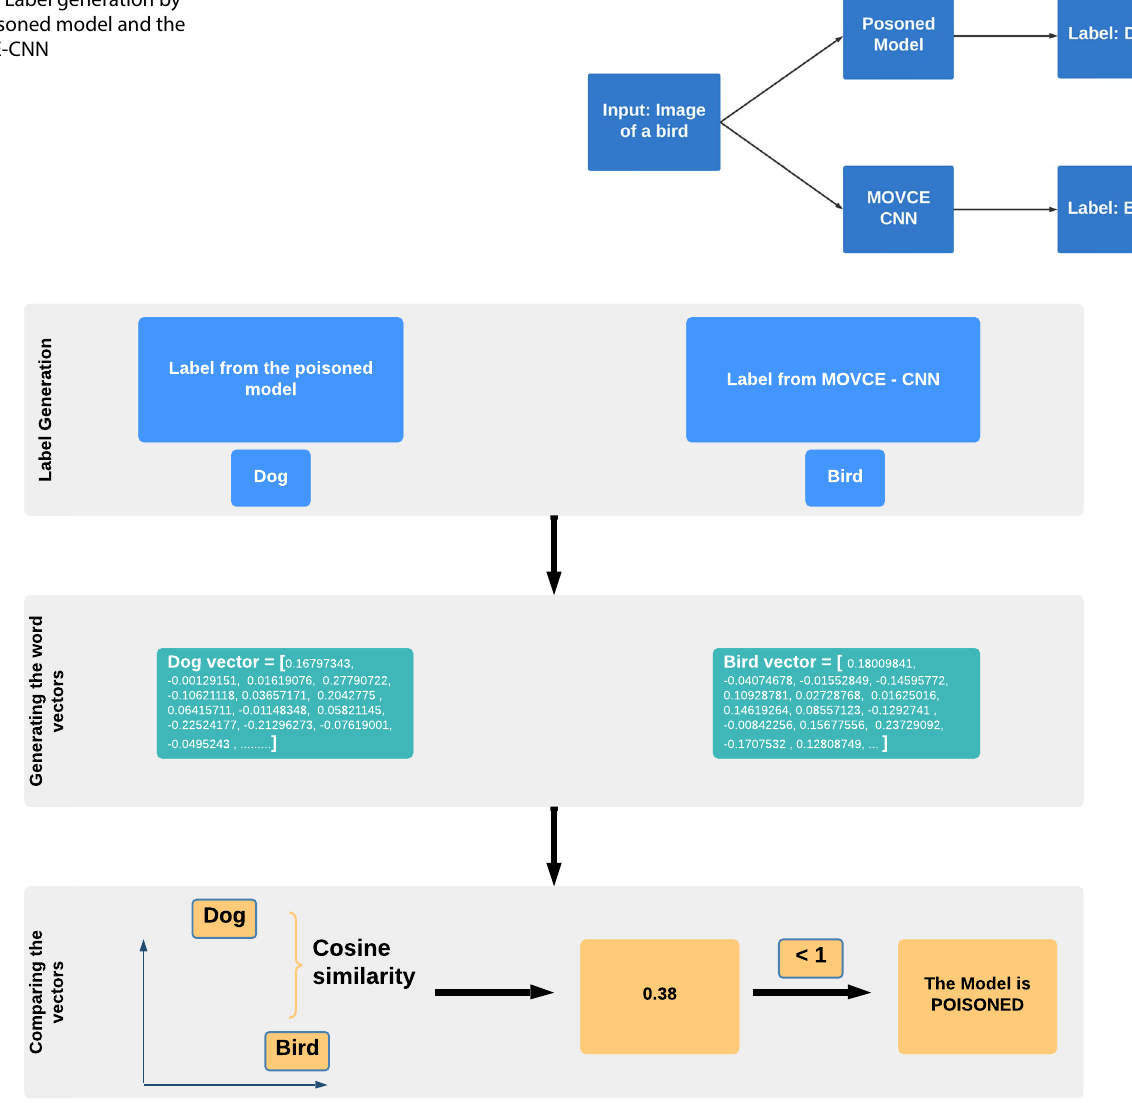
Fig. 13 Comparing the label vectors by